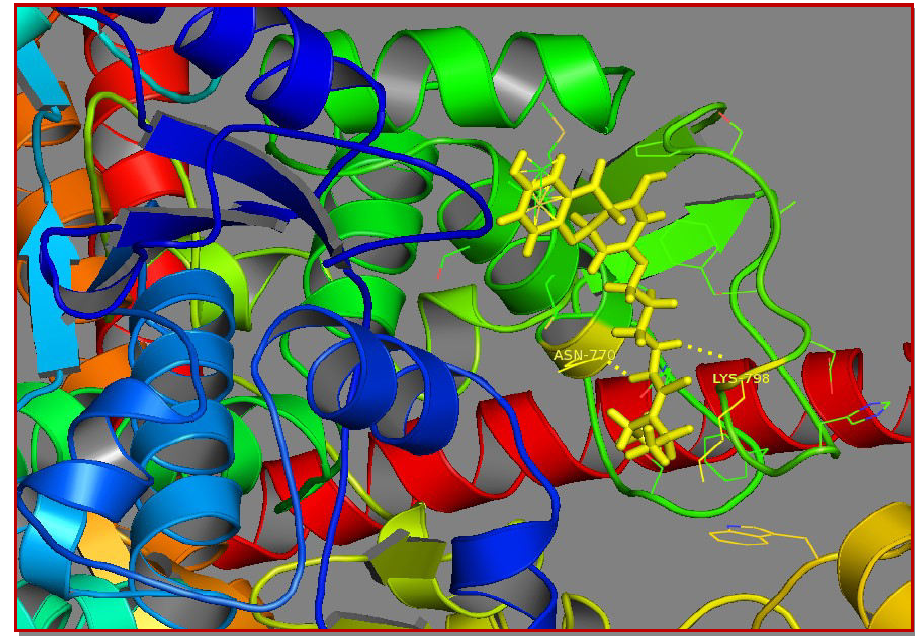
Figure 5: The polar contacts of the compound XM7 with the binding site of the modeled protein. The yellow dotted line shows the polar contacts formed and were found to be ASN770 and LYS